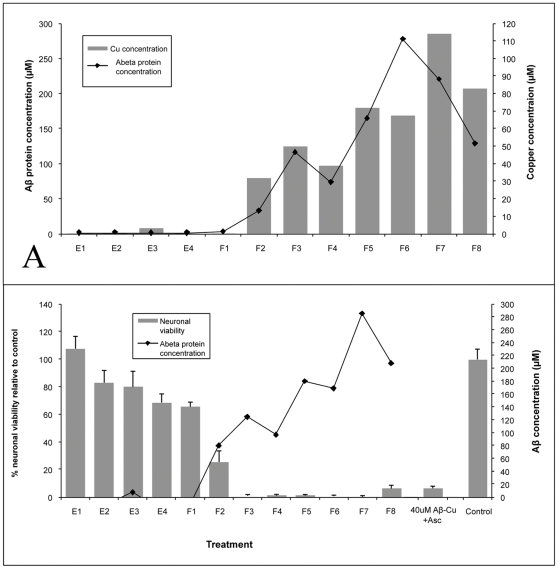
A 40µM Cu(II)-Aβ1–40 solution was separated on a PD MidiTrap™ G-25 column, and the protein (A280) and metal (ICP-MS) content of each fraction determined (A).Only those fractions containing Aβ peptide also contained copper (A), indicating that the Cu(II)-Aβ1–40 solution did not contain any free copper ions. The neurotoxicity of all fractions was subsequently tested, and only those containing Cu(II)-Aβ1–40 exhibited neurotoxic activity (B). E – eluate, F – collected fraction.